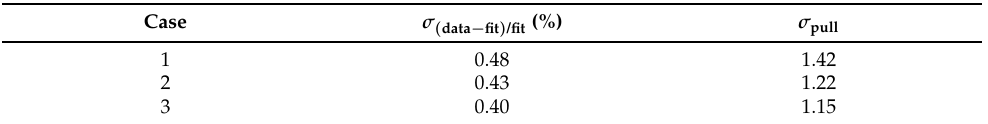
Table 34. Effect of LHC small-amplitude beam-separation scans on the precision of TPX3 luminosity measurements for layer 1 cluster-counting in LHC fill 6677. The width of the Gaussian fit σ ( data − fit ) /fit gives the precision of the measurement, and σ pull gives the width of the pull distribution fit with statistical uncertainties only. Three cases are under consideration: (1) fitting the LHC luminosity curve while ignoring the amplitude scans, (2) fitting the LHC luminosity curve with a separate luminosity amplitude after each scan, and (3) fitting the LHC luminosity curve with a separate luminosity amplitude, λ bb and λ g after each scan. Taken from Ref. [18].